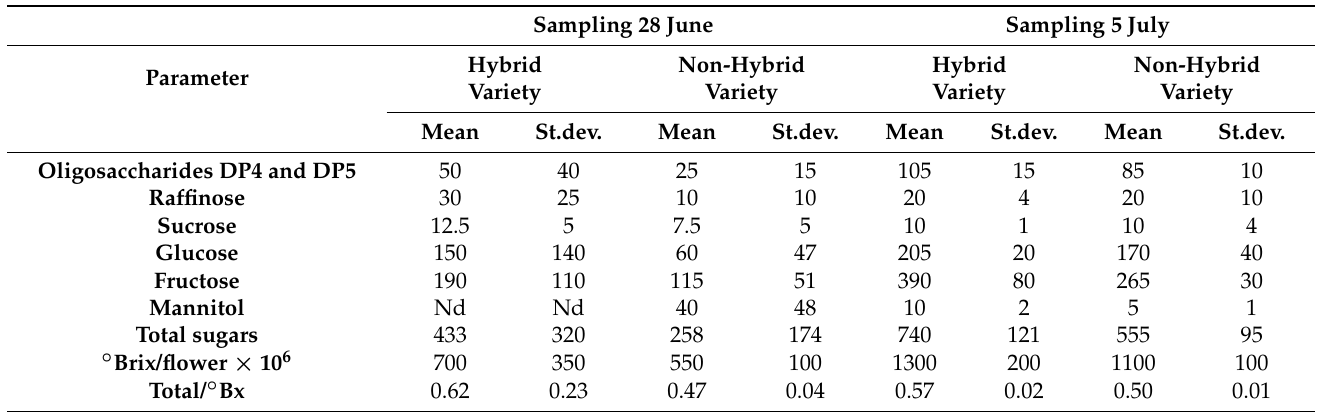
Table 5. Results of nectar analysis of the varietal study. Nd = not detectable. Units are expressed as µ g/flower, the ◦ Bx value is multiplied by